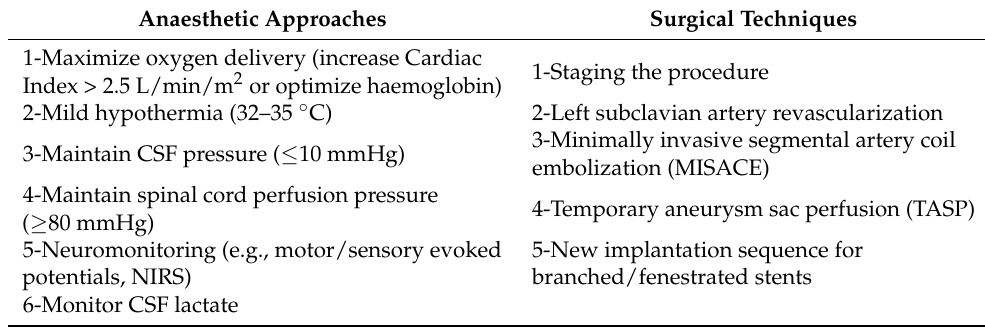
Table 2. Anaesthetic and surgical strategies to prevent and treat spine cord